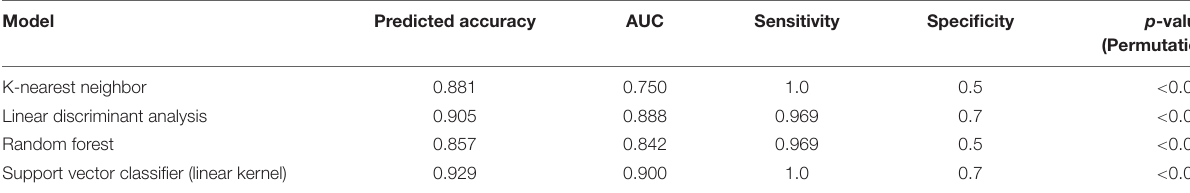
TABLE 1 | Performance of ML approaches for the estimation of predicted accuracy in patients to tDCS protocol.